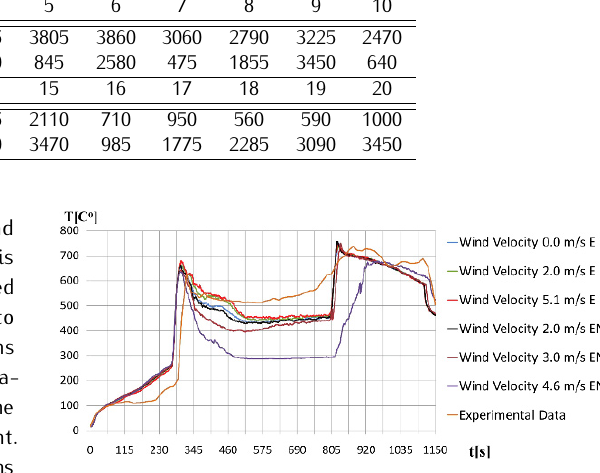
Figure 8. Averagehotgasestemperaturesofnumericalsimulationfor different wind profiles and fire experiment in Dalmarnock.